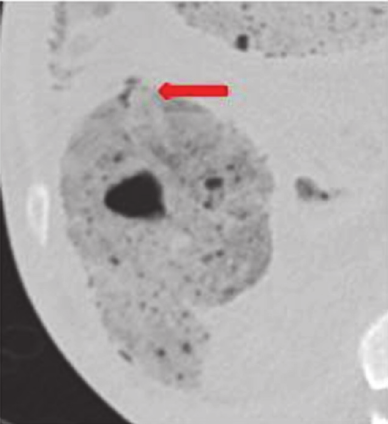
Figure 5: Axial CT image on lung windows (small field of view) confirming the perforation site (arrow).